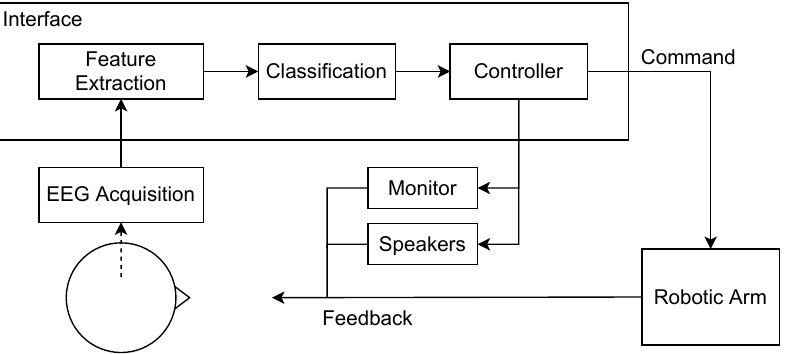
Figure 1. Schematic of the proposed system. EEG is recorded, followed by feature extraction. The classifier detects high power alpha waves and sends the selected commands to the robotic arm while providing feedback primarily through auditory